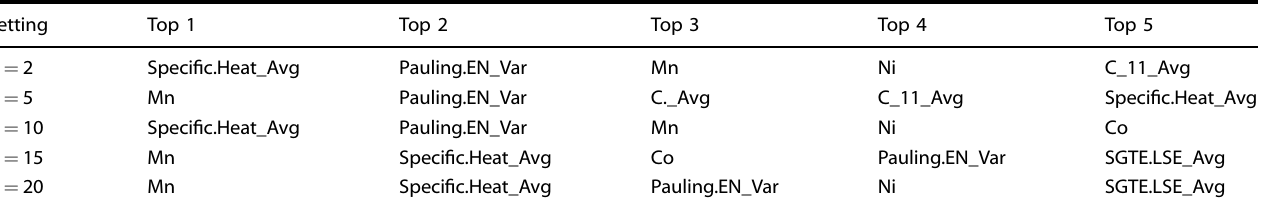
Table 7. The top fi ve important factors selected by BART for the maximum stacking fault energy (SFE) with the initial set of sample size N ∈ {2, 5, 10, 15,